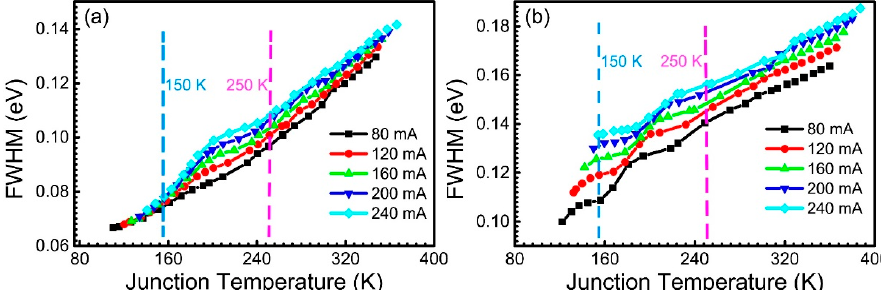
Figure 4. Relationship between the emission peak energy and T j for the ( a ) blue LED and ( b ) green LED.